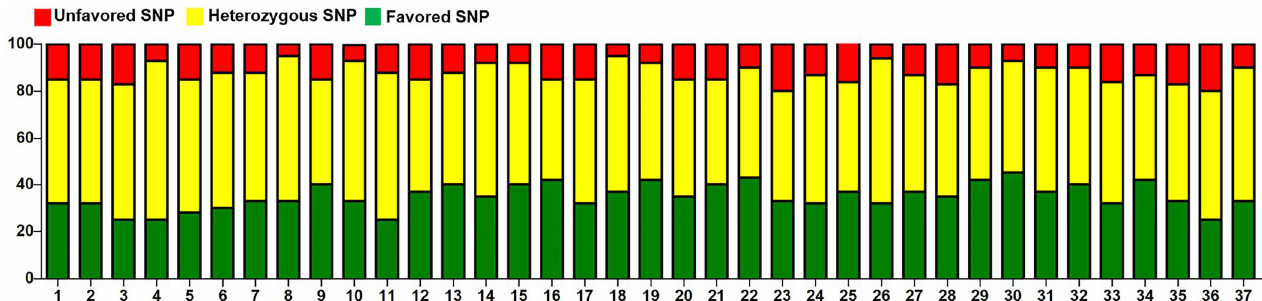
Figure 5. Ratio of three genotypes in mature crayfish from 37 locations in